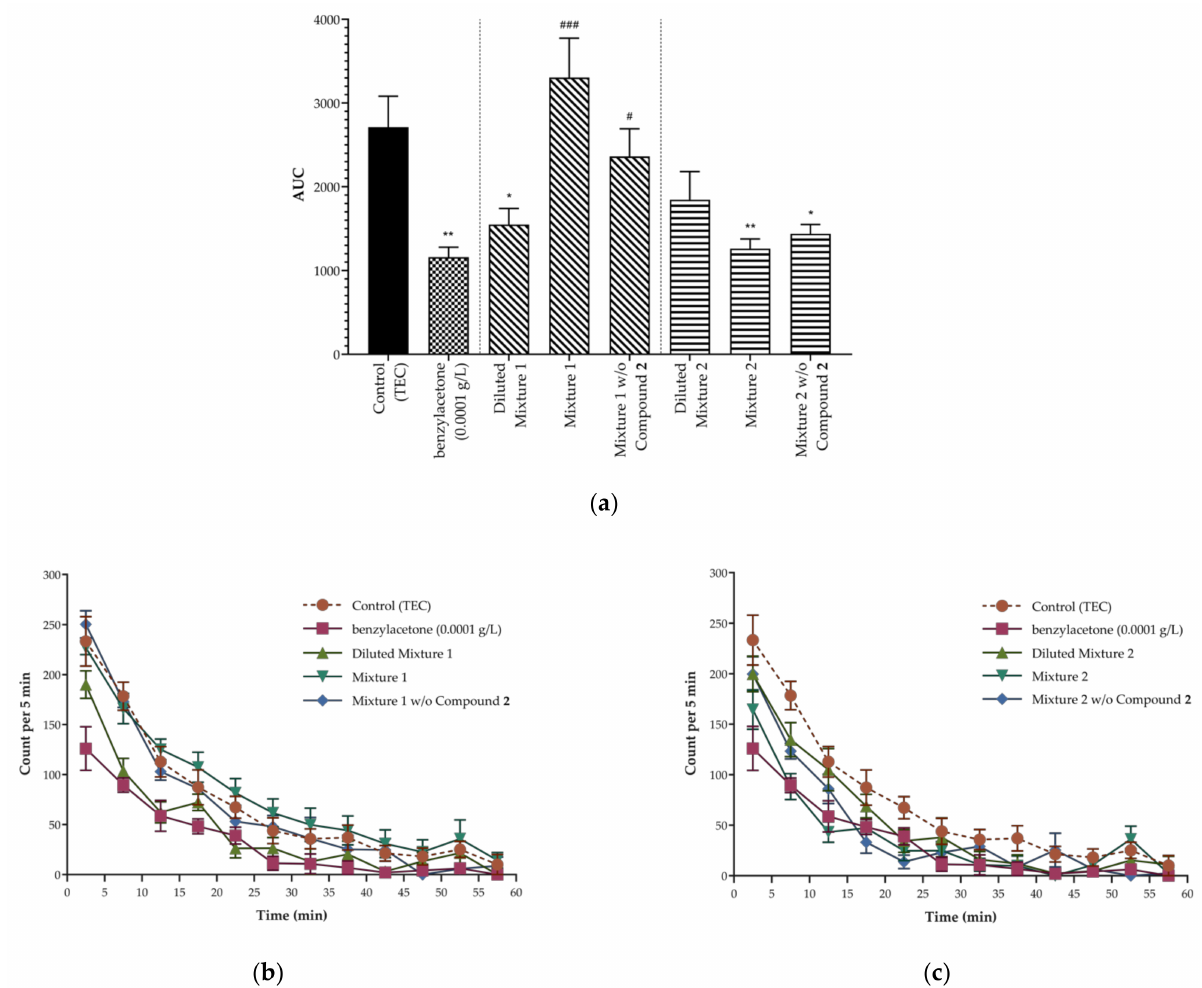
Figure 4. Total spontaneous motor activity ( a ), locomotor transition activity of mice treated with mixtures relating to K1 ( b ), and locomotor transition activity of mice treated with mixtures relating to K2 ( c ). Mixture 1, representing aroma constituents present in K1, contained all seven compounds; whereas Mixture 2, representing aroma constituents present in K2, only included benzylacetone, compounds 1 , 2 , and 4 . Data are expressed as mean ± SEM ( n = 6). Statistical differences vs. control group and benzylacetone (0.0001 g/L) were calculated using One-way ANOVA followed by Dunnett’s test. (significant against control: * p < 0.05, ** p < 0.01; significant against benzylacetone: # p < 0.05, ### p <